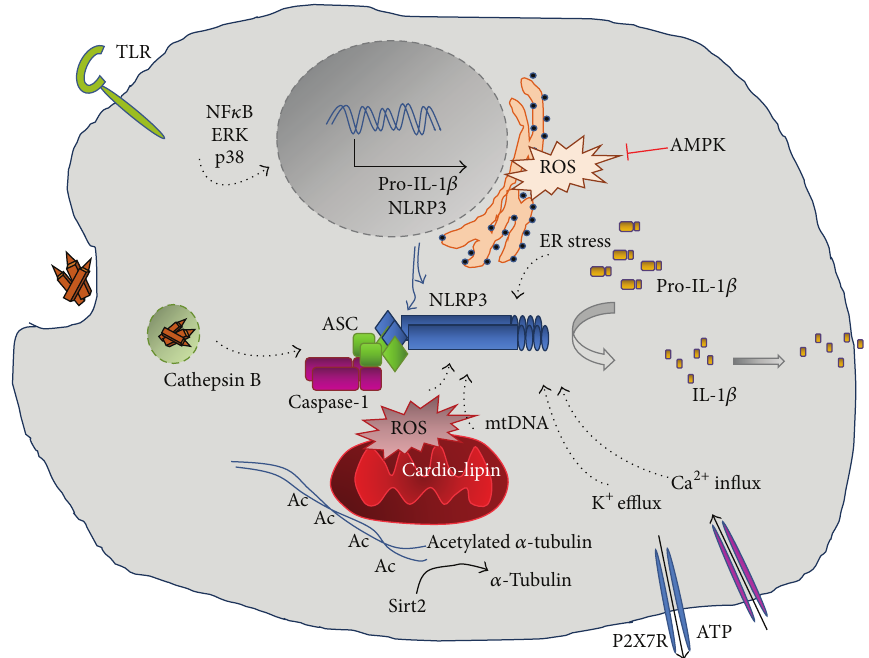
Figure 1: Basic mechanisms of NLRP3 inflammasome